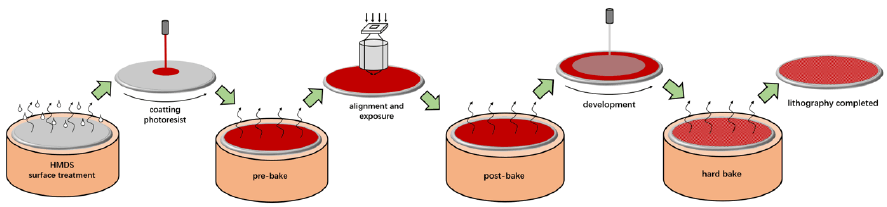
Figure 3. The basic process of lithography.